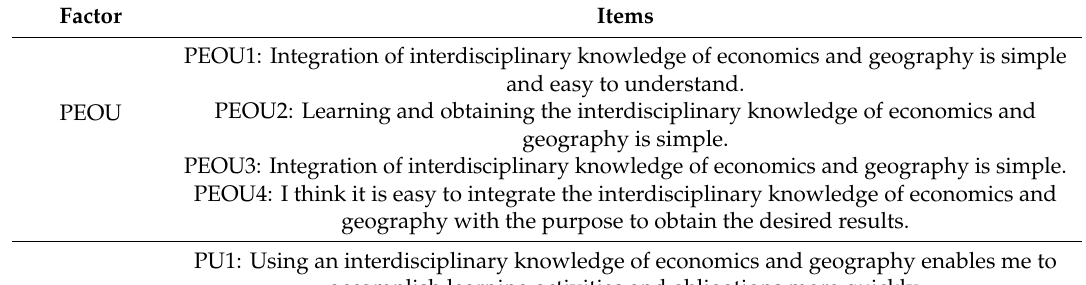
Table 1. Constructs of the research